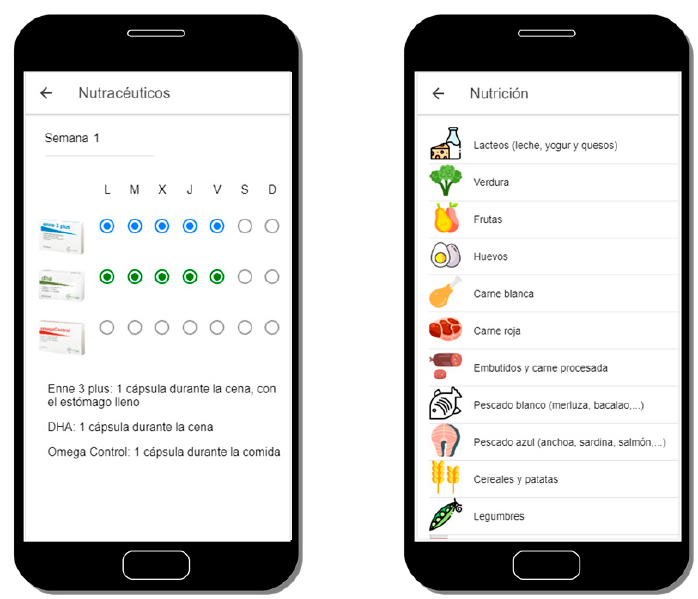
Figure 4. View of a nutritional supplement (nutraceutical) recommendation (left) and the main screen of the dietetic recommendation (right).